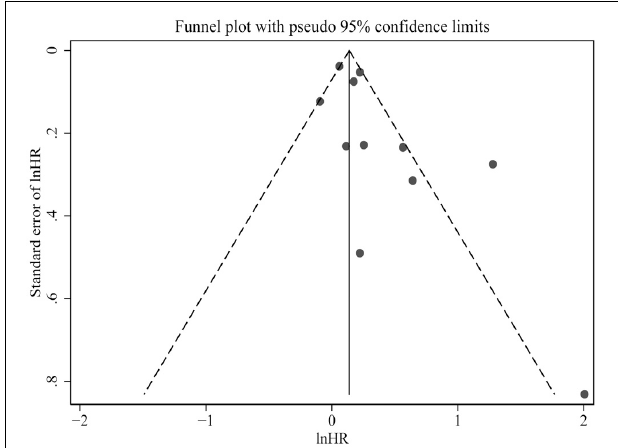
FIGURE 4 | Funnel plot presented potential publication bias in the pooled estimate of all-cause mortality risk. HR, hazard risk.